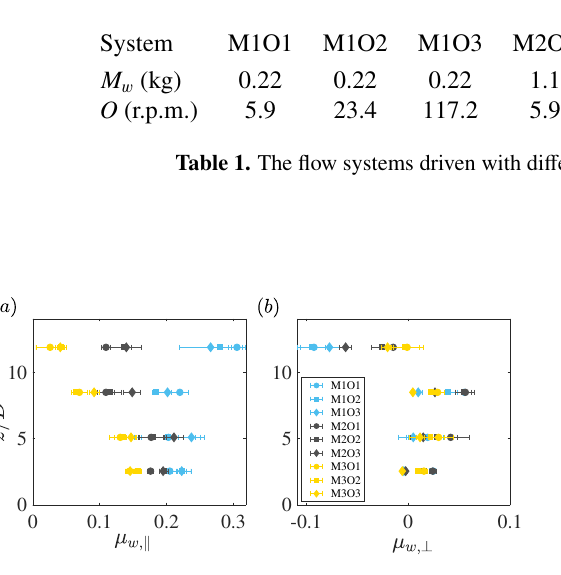
Figure 2. Depth profile for ( a ) streamwise wall friction coe ffi - cient µ w, (cid:107) = σ r θ /σ rr and ( b ) transverse wall friction coe ffi cient µ w, ⊥ = σ rz /σ rr .